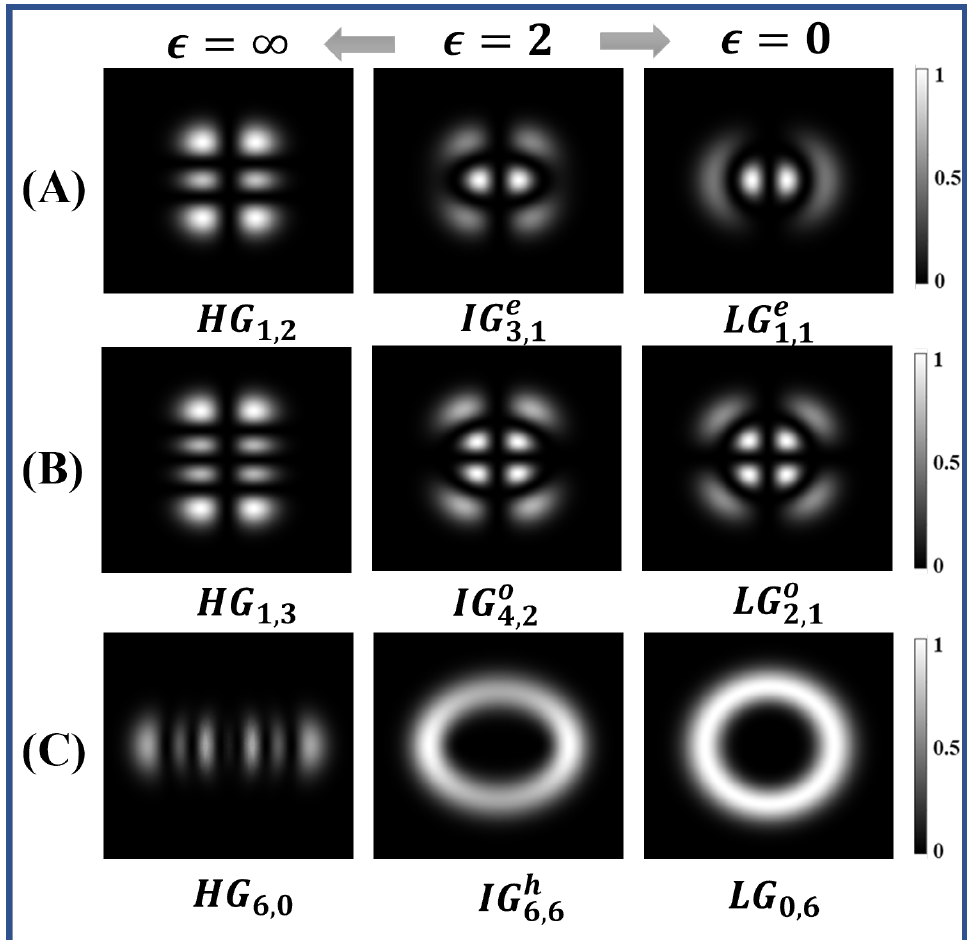
Figure 3. Transformation of Ince–Gaussian beam (center) into Hermite–Gaussian beam (left) and Laguerre–Gaussian beam (right) at different elliptical parameter ( (cid:101) ) values. ( A ) Conversion of IG e for (cid:101) = 2 into HG 1,2 for (cid:101) = ∞ and LG 1,1 for (cid:101) = 0. ( B ) Conversion of IG o (cid:101) = ∞ and LG 2,1 for (cid:101) = 0. ( C ) Conversion of IG h (cid:101) =